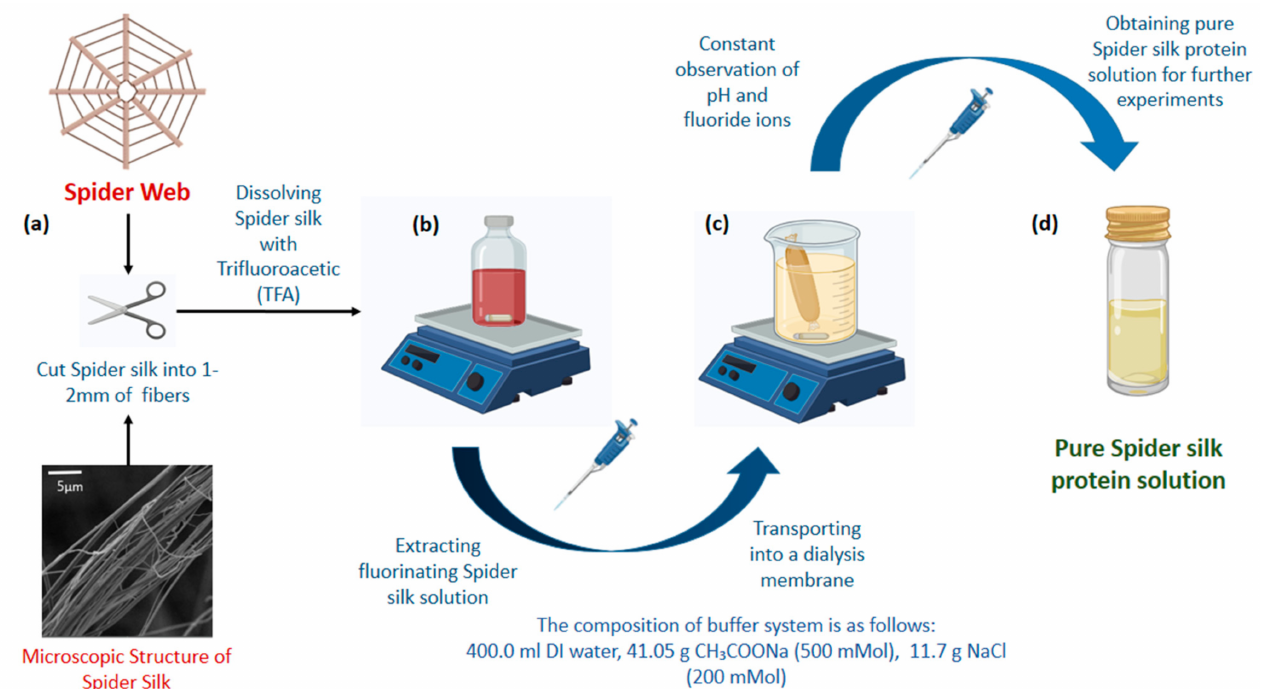
Figure 1. Scheme of the spider silk protein solution preparation. ( a ) Obtaining and cutting spider silk into 1–2 mm pieces (reduces dissolution time). ( b ) Fluorinated spider silk solution after constant mixing with trifluoroacetic acid (TFA). ( c ) Dialysis of fluorinated spider silk solution against buffer (400 mL DI water, 41.05 g CH 3 COONa (500 mMol), 11.7 g NaCl (200 mMol)). ( d ) Obtaining pure spider silk solution after constant observations of pH and fluorine ions with CaCl 2 quality